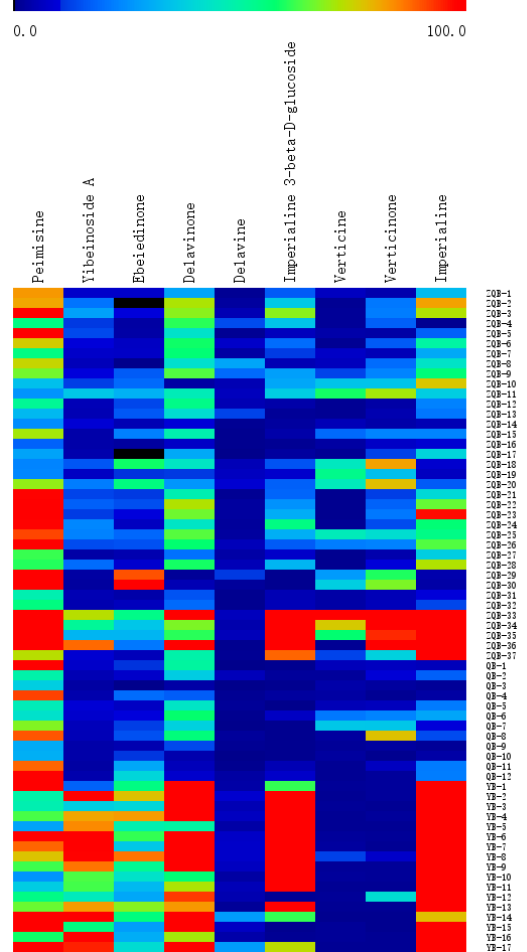
Figure 2. The heatmap of nine alkaloids in 58 batches of FCB and FPB samples